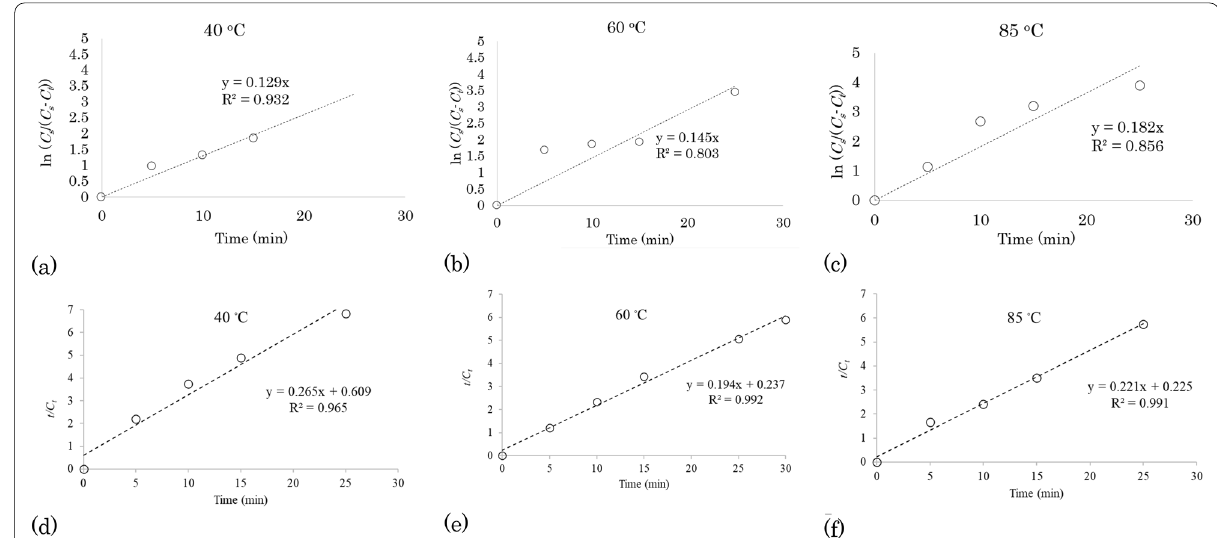
Fig. 1 First-order kinetic models ( a – c ) and second-order kinetic models ( d – f ) of extraction of total polyphenolic compounds from apple pomace with water-only at different